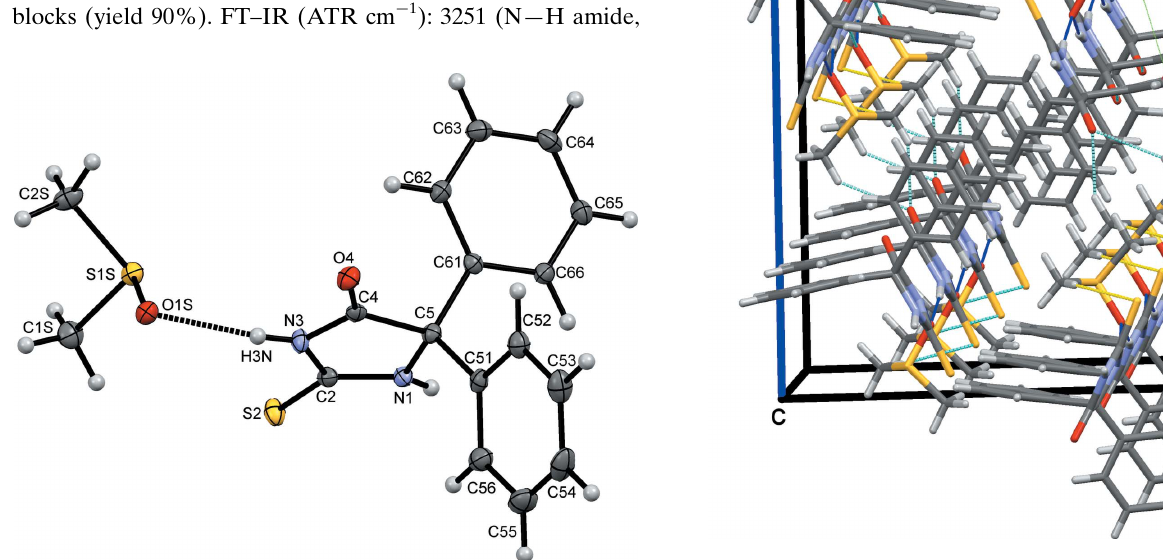
Figure 3 Overall packing, viewed along the a -axis direction. For clarity, only